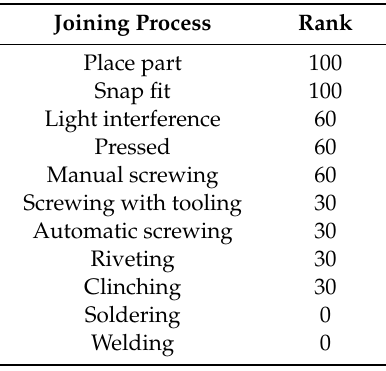
Table 12. Membership functions in tabular form of linguistic variables for processes.